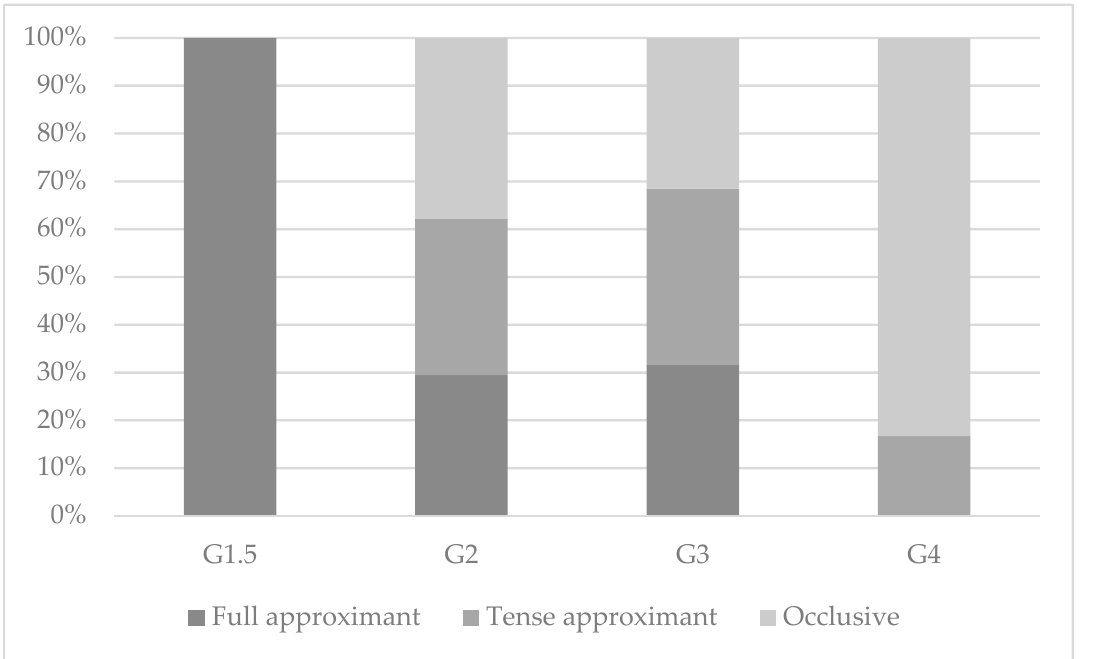
Figure 7. Rates of /d/ production types by generation.